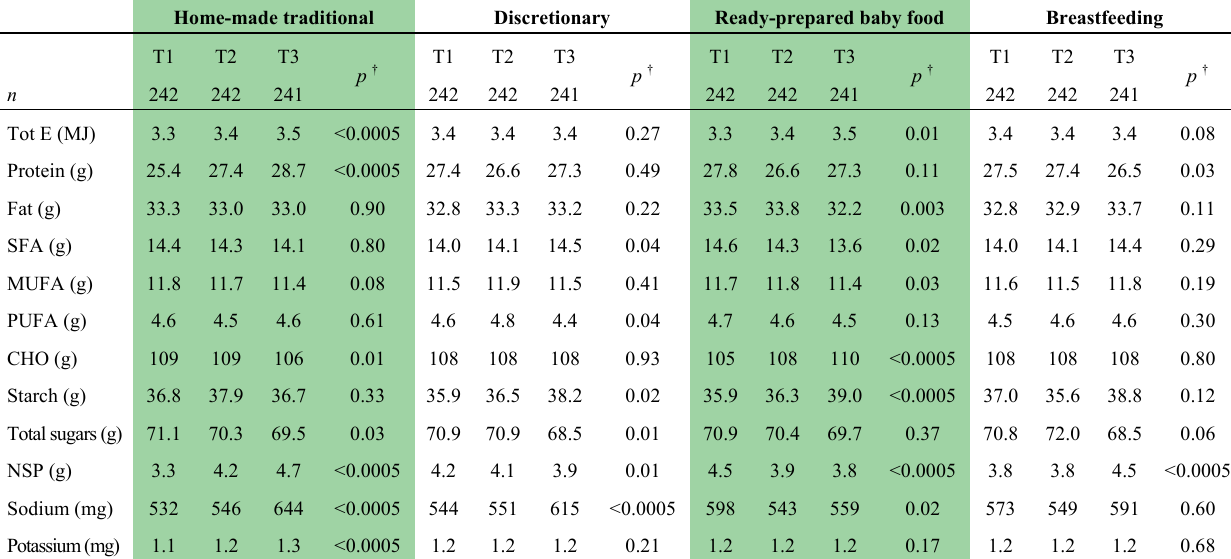
Table 2. Median daily energy intake and energy-adjusted nutrient intake * at 8 months of age, according to tertiles of dietary pattern scores at 6 months ( n =